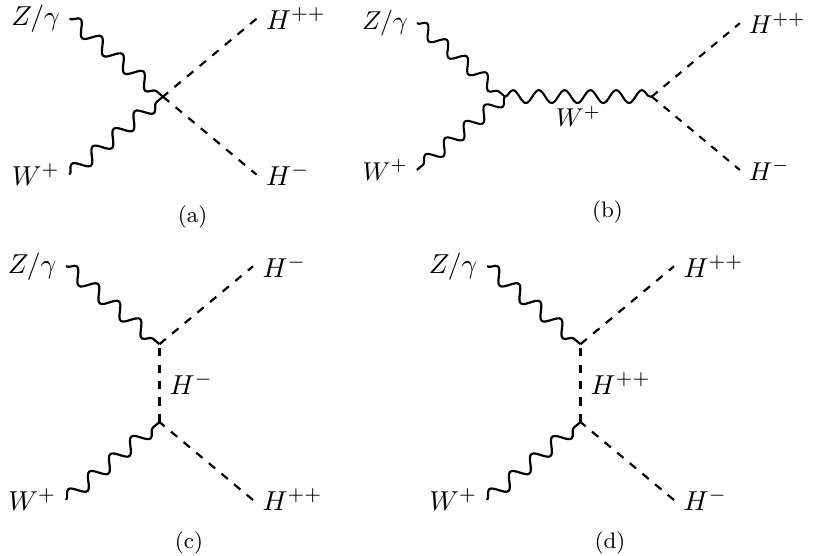
Figure 7 . Cross sections of H ++ H −− pair production as a function of the collider energy (left) and heavy Higgs masses m (right) at muon colliders, through µ + µ − annihilation (dashed H ±± lines) and VBF (dotted lines) processes. Their sum is shown as solid lines. We have chosen four benchmark masses of the H ±± , that are 0 . 5 , 1 , 3 and 5 TeV in the left panel. In the right panel, the √ c.m. energy is assumed to be s = 3 , 10 , 20 or 30 TeV.